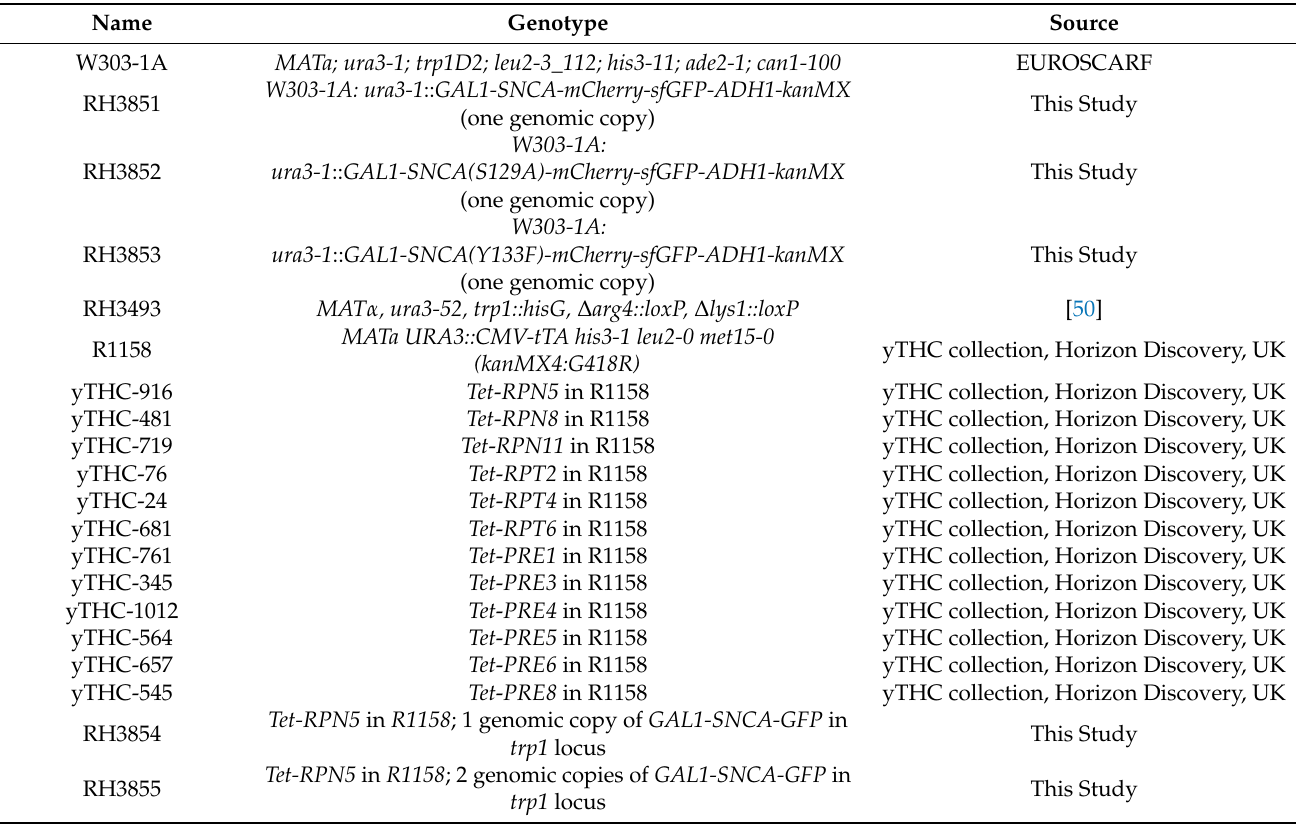
Table 1. Yeast strains used in this